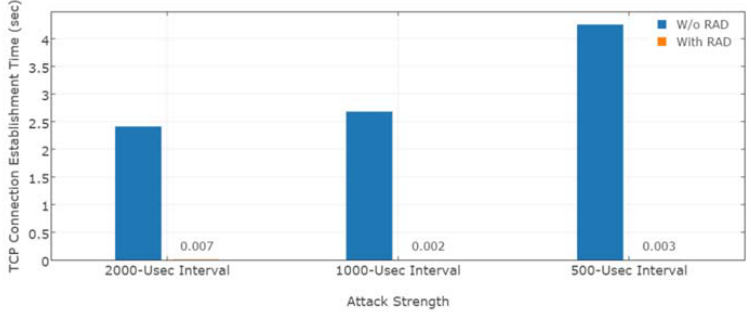
Figure 11. Average TCP connection establishment time vs. attack strength.